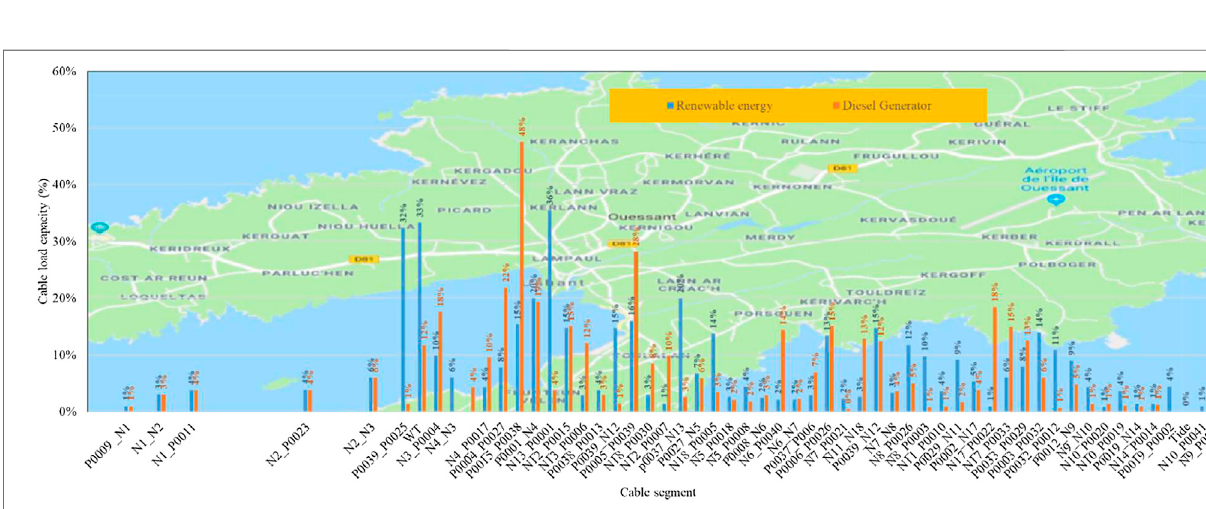
Frontiers in Energy Research |